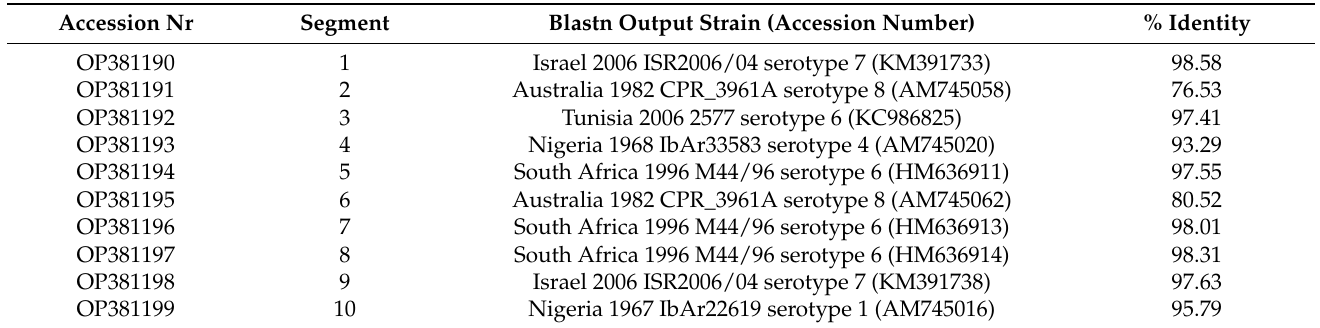
Table 1. Blast results for nucleotide and amino acid sequences for EHDV-8 /17 TUN 2021